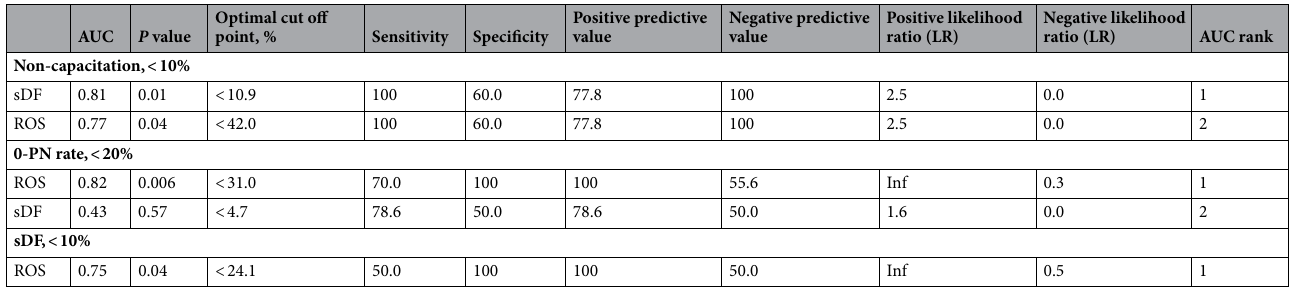
Table 1. Discriminating power (the AUC analysis) of ROS for sperm non-capacitation and fertilization rates. In order to identify the best predictive variables for predicting a high rate of fertilization, a receiver operating characteristic (ROC) curve analysis was performed using the easyROC web-tool. Optimal cut-off points were determined by maximizing the Youden index. The results were divided into distinct groups as follows: (1) low rate of non-capacitation (< 10%) and (2) low rate of 0-PN, oocyte which did not reach the 2-PN stage (< 20%). In addition, the optimal level of ROS for detecting the incidence of low DNA fragmentation (< 10%) was estimated using the AUC analysis. sDF sperm DNA fragmentation, NC non-capacitation, AR acrosome reaction, PN